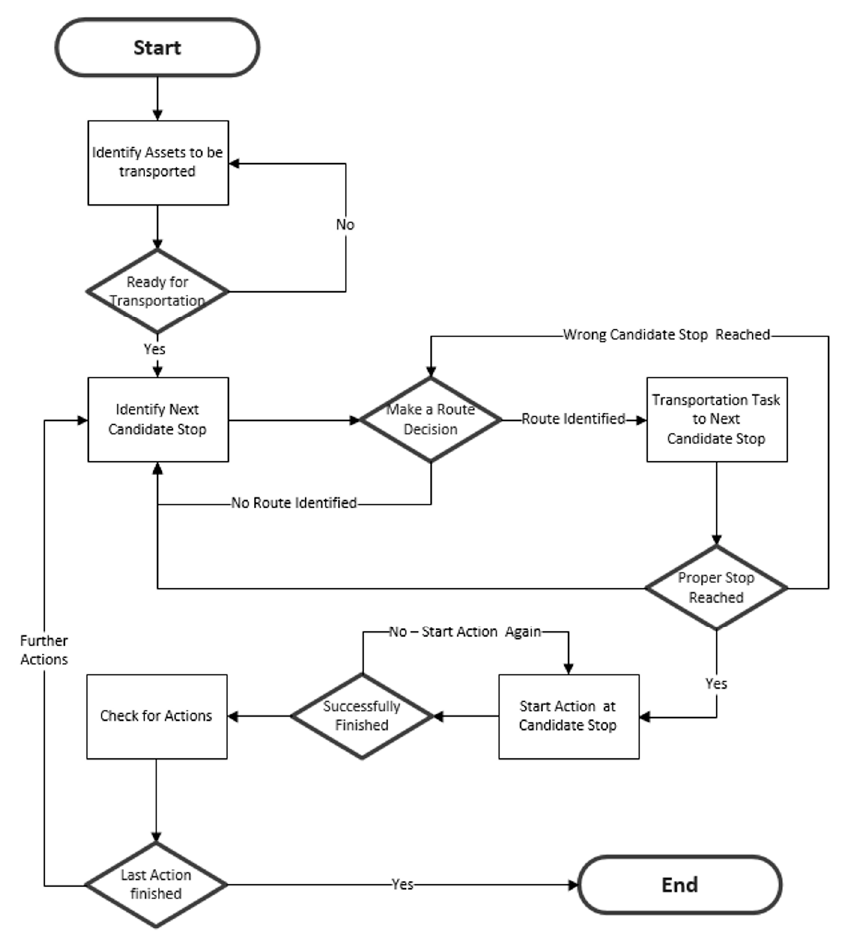
Figure 2. Smart transportation process in a manufacturing environment. The general process is broken down into several sub-processes including the actions to be performed at certain stops on the route (e.g., pickup or delivery of a production asset).